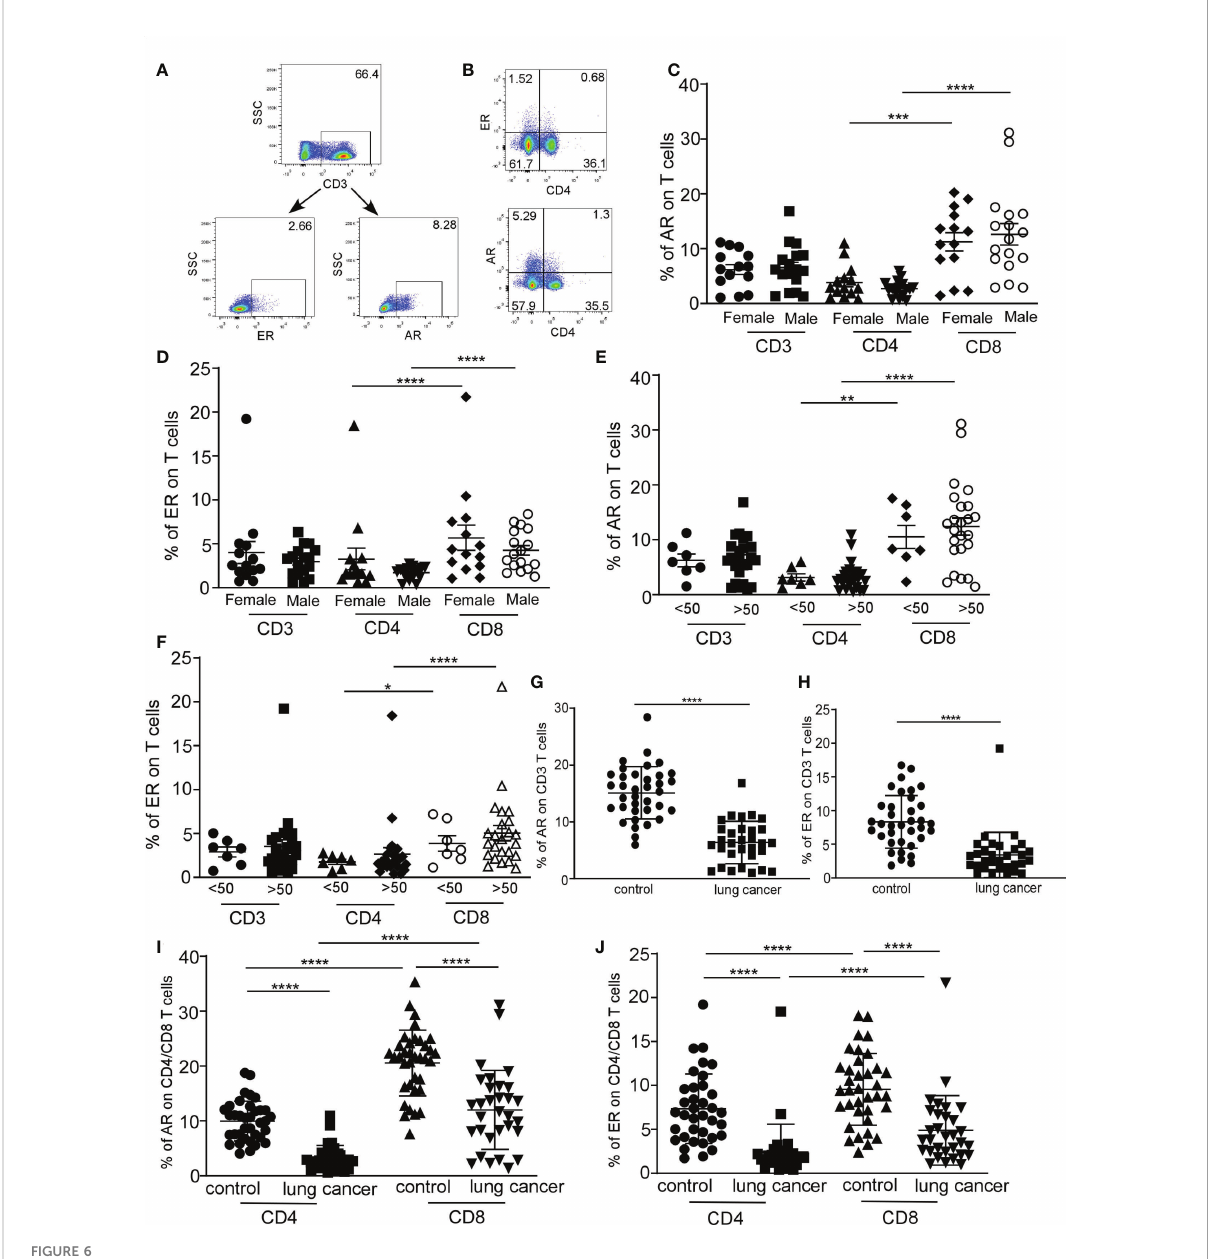
FIGURE 6 The distribution of estrogen receptor (ER) and androgen receptor (AR) on T cells in lung cancer patients was analyzed by FACS. Representative fl ow cytometric analyses of AR and ER expression on CD3 T cells (A) and representative fl ow cytometric analyses of CD4+/CD8-ER+, CD8 +/CD4-ER+T cells (top quadrant), CD4+/CD8-AR+, and CD8+/CD4-AR+T cells (bottom quadrant), gated on the CD3 populations (B) . The percentage of AR expression on T cells (C) and ER expression on T cells (D) in CD3, CD4, and CD8 T cells from female and male lung cancer patients. The percentage of AR expression on T cells (E) and ER expression on T cells (F) in CD3, CD4, and CD8 T cells from lung cancer patients at different ages. The percentage of AR (G) and ER (H) expression on CD3+T cells from lung cancer patients and control. The percentage of AR (I) and ER (J) expression on CD4/CD8+T cells from lung cancer patients and control. *** P < 0.001, **** P < 0.0001; Mann – Whitney test (two-tailed) and nonpaired Student ’ s t -test. * P<0.05,